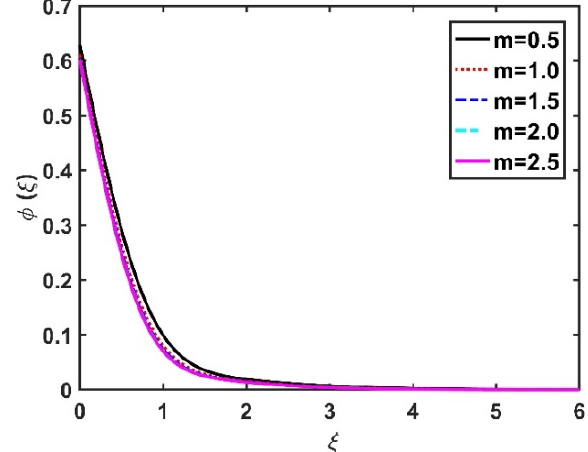
Figure 16. Impact of 𝑀 on 𝜙(cid:4666)𝜉(cid:4667) .